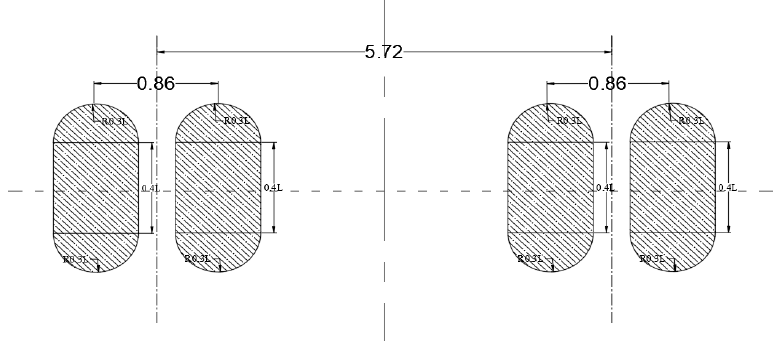
Table 2. B737-800 model calculation reference data.